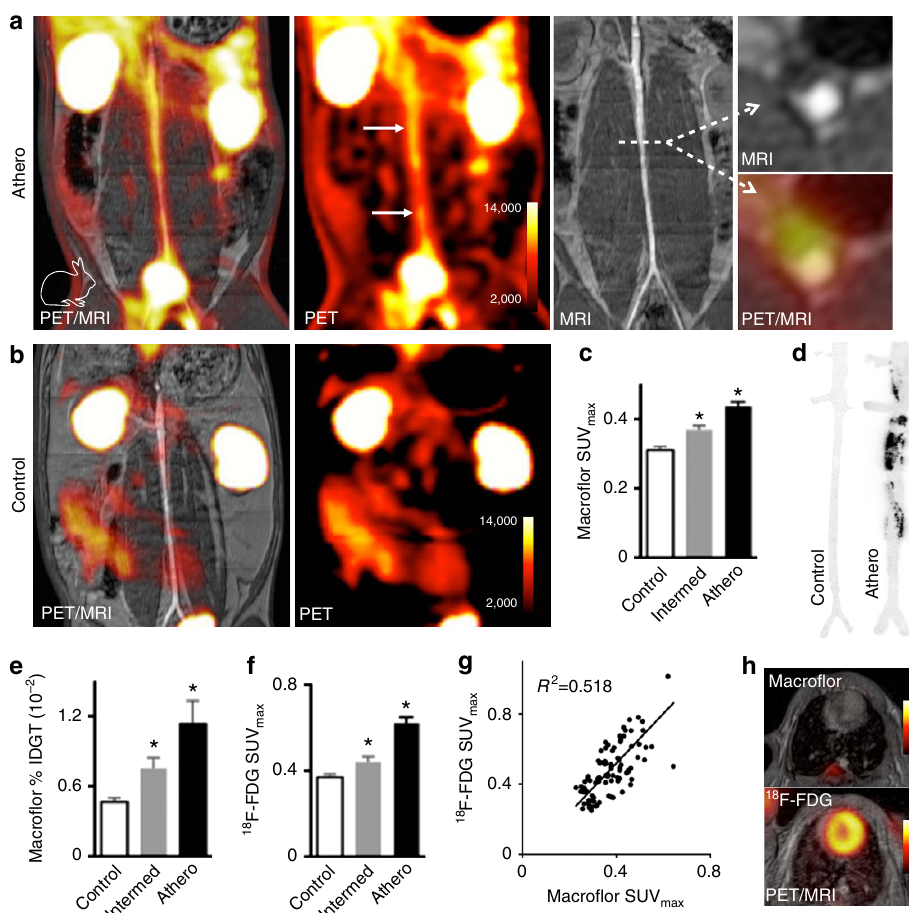
Figure 4 | PET imaging of inflammatory atherosclerosis in rabbits. Macroflor PET imaging detects atherosclerotic aortic plaques in rabbits, with distinct differences from 18 F-FDG. ( a ) PET/MR images obtained in rabbits with atherosclerosis and ( b ) control rabbits. ( c ) Standard uptake values (SUV) in infrarenal aorta after Macroflor injection in control rabbits, rabbits with intermediate and full aortic balloon infrarenal aorta denudation. Experiments were done in four rabbits per group, with analysis in 38–40 aortic regions (one-way analysis of variance (ANOVA)). ( d ) Autoradiography of the abdominal aorta in a control rabbit and a rabbit with atherosclerosis after Macroflor injection, representative images of 12 autoradiography exposures ( n ¼ 4 per group). ( e ) Ex vivo gamma counting reports percent injected dose per gram aortic tissue (%IDGT (percent injected dose per gram tissue), n ¼ 4 per group, one-way ANOVA). ( f ) Two days before macrophage imaging with Macroflor, the same rabbits underwent 18 F-FDG PET imaging to report aortic SUV in infrarenal aorta ( n ¼ 4 rabbits per group, analysis in 23–38 aortic regions, one-way ANOVA). ( g ) Correlation of 18 F-FDG with Macroflor in vivo PETsignal ( P o 0.001, n ¼ 12 rabbits). ( h ) Cardiac PET images with respective agents. Data are shown as mean ± s.e.m., * indicates P o 0.05. Rabbit cartoon image is reproduced from the servier medical art image data bank